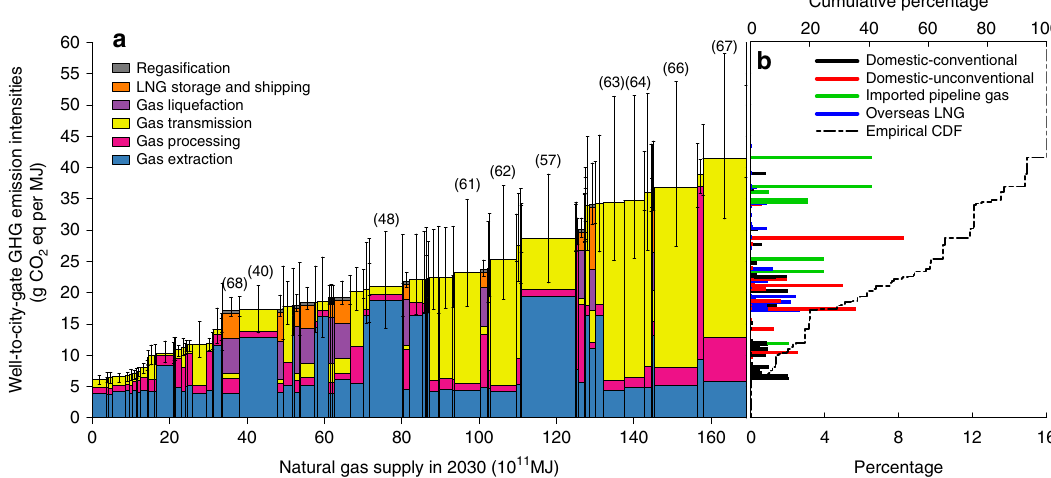
Fig. 4 Well-to-city-gate GHG intensity supply curve of natural gas for China in 2030. a The GHG intensity supply curve with emission breakdowns for individual processes. Bars with numbers in parentheses on top are the top 10 gas fi elds with the largest supply in 2030. The numbers in parentheses are their corresponding gas fi eld number in Table 1 and Fig. 1. Error bars represent the 90% CI of the estimates with Monte Carlo Simulation of uncertain parameter inputs (see Supplementary Discussion 1 and 2 for details). b Empirical probability mass function and empirical cumulative probability function (CDF). Different colors in the empirical probability mass function indicate different categories of gas sources. GHG intensities in the fi gure are based on GWP 100 . Source data are provided in a Source Data fi